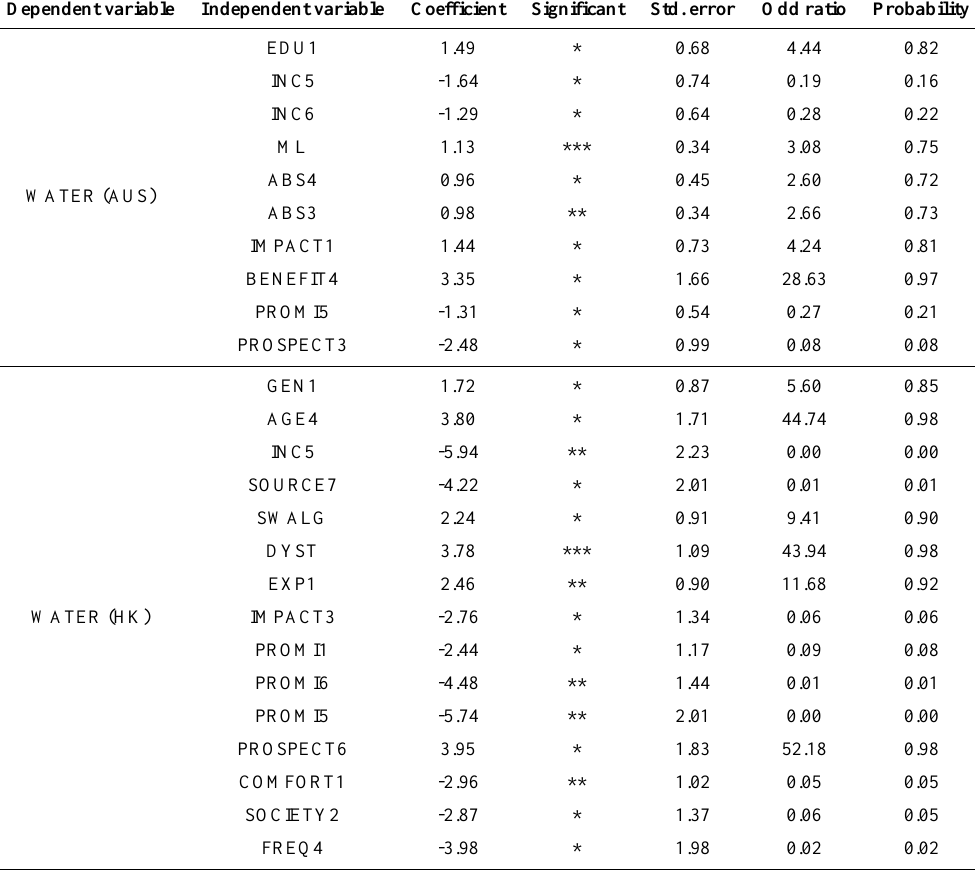
Table A-19. Water